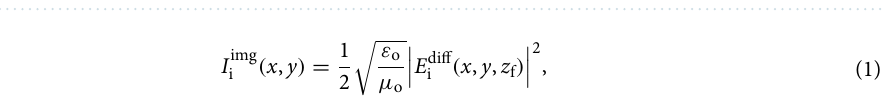
Figure 1. Backscatter DIH measurement and imaging principle for a single wavelength. The measurement geometry is shown in ( A ), where an aerosol particle is illuminated by an incident beam propagating along the positive z -axis. Backscattered light from the particle is reflected toward a sensor by a beamsplitter where it is combined with the reference beam propagating along the x -axis. This beam is a copy of the incident beam and originates from one half of a Mach–Zehnder interferometer as described further in the “Methods” section. The sensor’s pixel array S h records the interference pattern produced by the reference beam and the particle’s backscattered light, i.e., the backscattered hologram. The reflected portion of the incident and reference beams and the transmitted portion of the backscattered light at the beamsplitter do not affect the measurement and are not shown for clarity. The image reconstruction geometry is shown in ( B ). Given the beamsplitter in ( A ), the hologram is envisioned in the x – y plane and Fresnel diffraction theory 52 is applied to reconstruct the image in the S img plane. The various parameters needed to implement the reconstruction process in the “Methods”section are defined in ( B